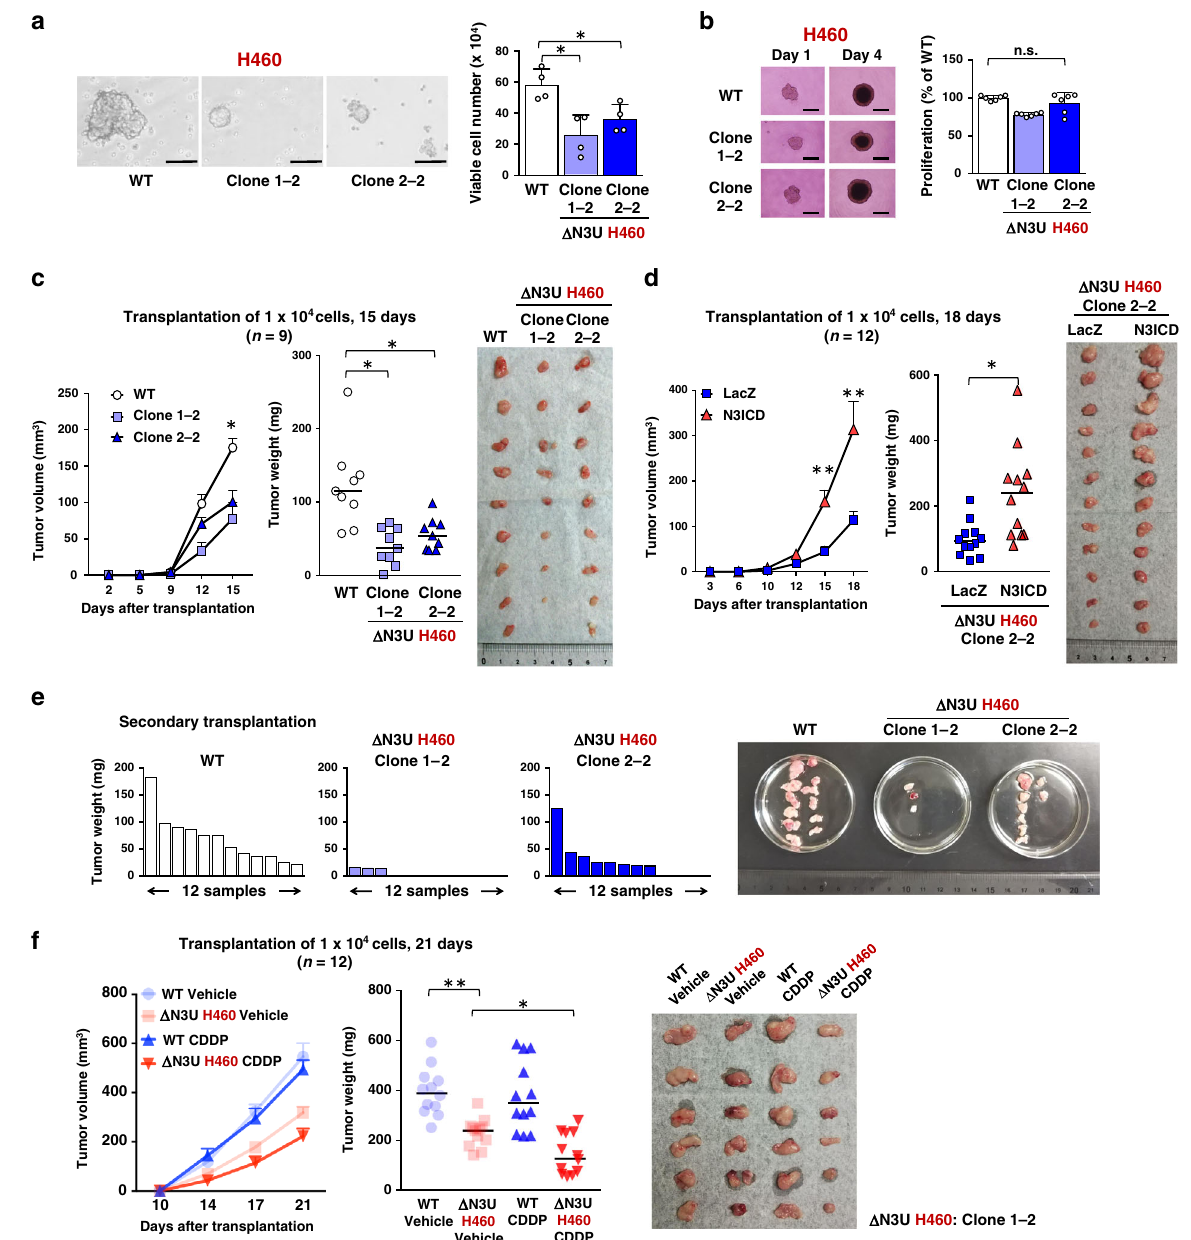
Fig. 9 The NOTCH3 enhancer promotes tumor-initiating activity of NRF2-activated NSCLCs. a Oncosphere growth of Δ N3U and wild-type (WT) H460 cells (left panel). Scale bars indicate 100 μ m. Viable cells were counted after trypsinization (right panel). Average cell numbers and SD from four independent experiments are shown. Comparison was made between two cell groups; WT and each mutant clone. Two-sided Student ’ s t test was performed. * p < 0.05. b Spheroid growth of Δ N3U and WT H460 cells (left panels). Scale bars indicate 100 μ m. Cell numbers were estimated using a cell counting kit on day 4 (right panel). Average cell numbers and SD from six independent experiments are shown. The average number of WT H460 cells was set as 100%. Two-sided Student ’ s t test was performed. n.s.: not signi fi cant. c Xenograft experiment of Δ N3U and WT H460 cells ( n = 9 each; number of xenograft tumors). A photograph shows xenograft tumors at the time of tumor weight measurement on day 15. Horizontal bars indicate the median tumor weight (middle panel). Data are presented as mean + SEM (left panel). Two-sided Wilcoxon rank sum test was performed. * p < 0.05. d Xenograft experiment of Δ N3U H460 Clone 2 – 2 cells with LacZ and N3ICD ( n = 12 each; number of xenograft tumors). A photograph shows xenograft tumors at the time of tumor weight measurement on day 18. Horizontal bars indicate the median tumor weight (middle panel). Data are presented as mean + SEM (left panel). Two-sided Wilcoxon rank sum test was performed. * p < 0.05, ** p < 0.005. e Serial transplantation experiment of Δ N3U and WT H460 cells. Each graph shows the weight of tumors in the secondary transplantation. A photograph shows tumors at the time of weight measurement in the secondary transplantation. f CDDP treatment experiment into nude mice after transplantation of Δ N3U and WT H460 cells. A representative photograph shows xenograft tumors at the time of tumor weight measurement on day 21. Horizontal bars indicate the median tumor weight (middle panel). Data are presented as mean + SEM (left panel). One-way ANOVA followed by the Bonferroni post hoc test was performed. * p < 0.05, ** p < 0.005. n = 12 biologically independent samples in each four